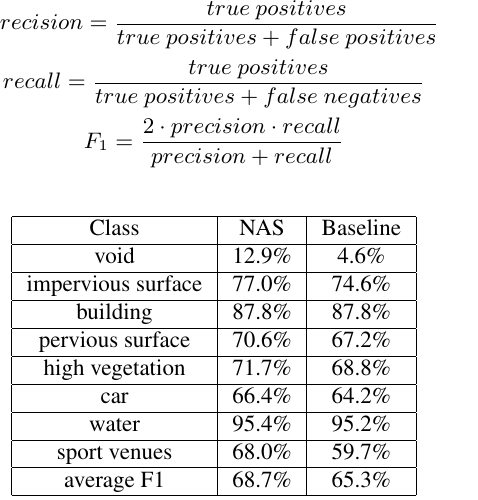
Table 3. Summary of F1 scores achieved with each network